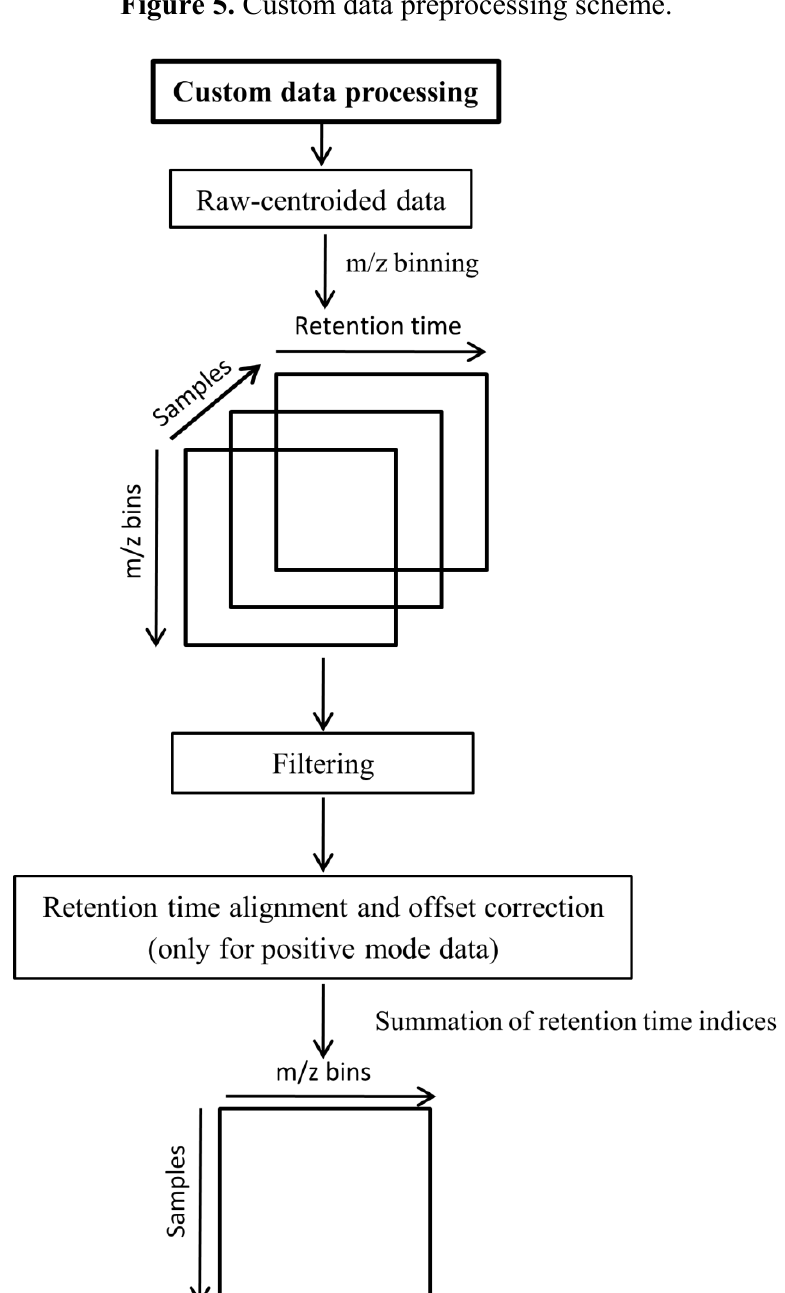
Figure 5. Custom data preprocessing